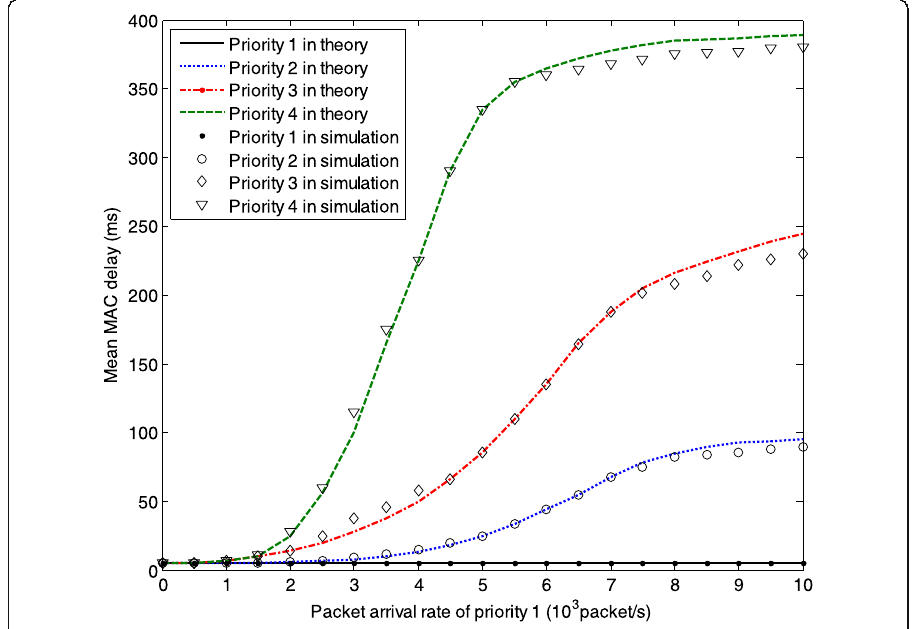
Fig. 6 Mean MAC delay of different prority service in MCLA protocol